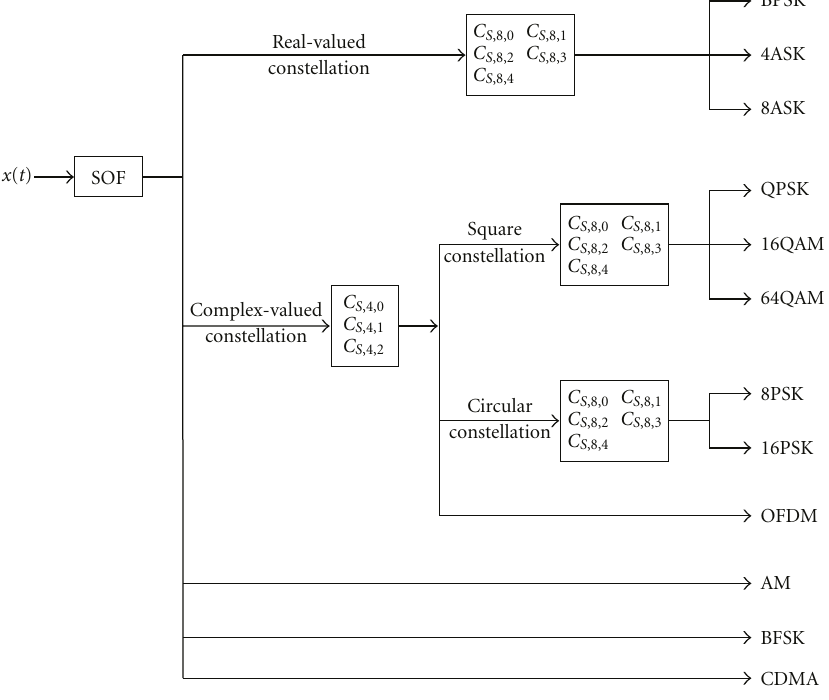
Figure 9: Proposed system diagram.